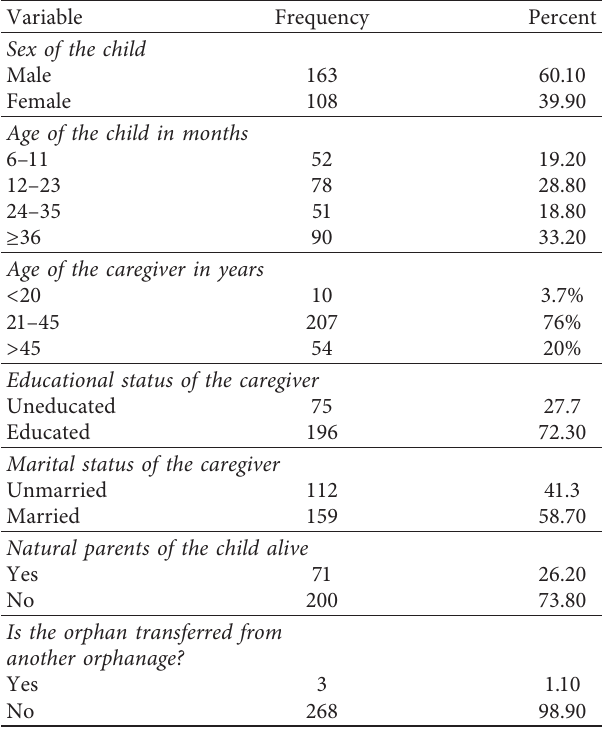
Table 1: Sociodemographic characteristics of study participants living in orphanages, Addis Ababa, Ethiopia, 2020 ( n � 271).